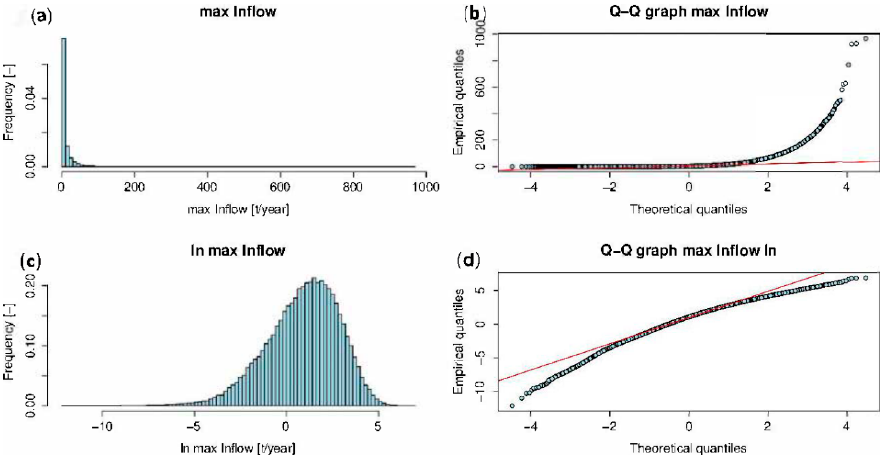
Figure 3. The statistical distribution of Inflow100 values in the watershed threat database represented by histograms and Q-Q plots. It does not corresponds to normal statistical distribution ( a , b ). It corresponds to log-normal statistical distribution ( c , d ).